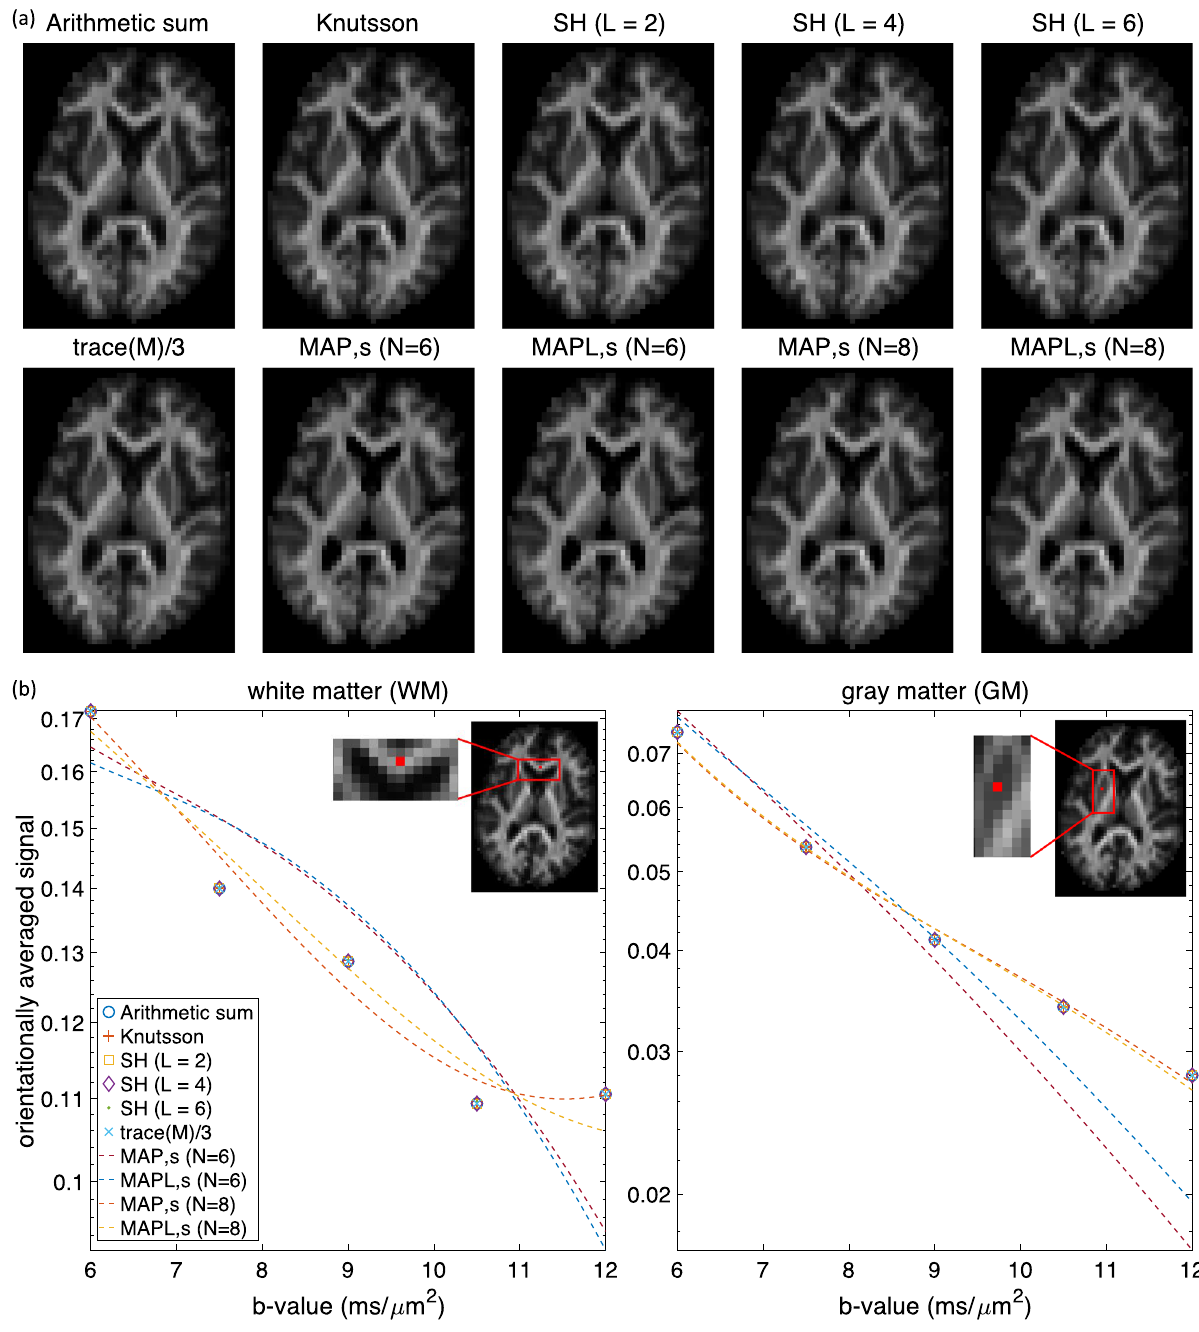
Figure 7. The estimated orientationally averaged signal using different methods for in vivo data on ( a ) 6 ms / µ m 2 . ( b ) in a white matter (left plot) and a gray matter (right plot) voxel for an axial slice for b = 6, 7.5, 9, 10.5 and 12 ms / µ m 2 in shell-based methods and b b = based